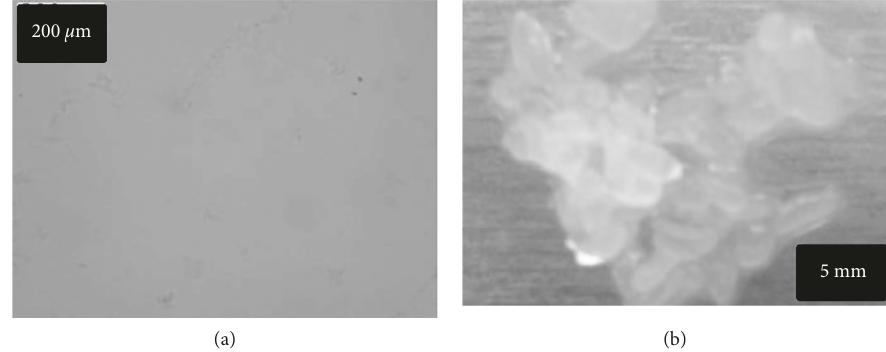
Figure 8: Micrographs of hydrogel samples made of AA 0.5% by (a) ionotropic gelation with CaCl complexation with CS 0.01%